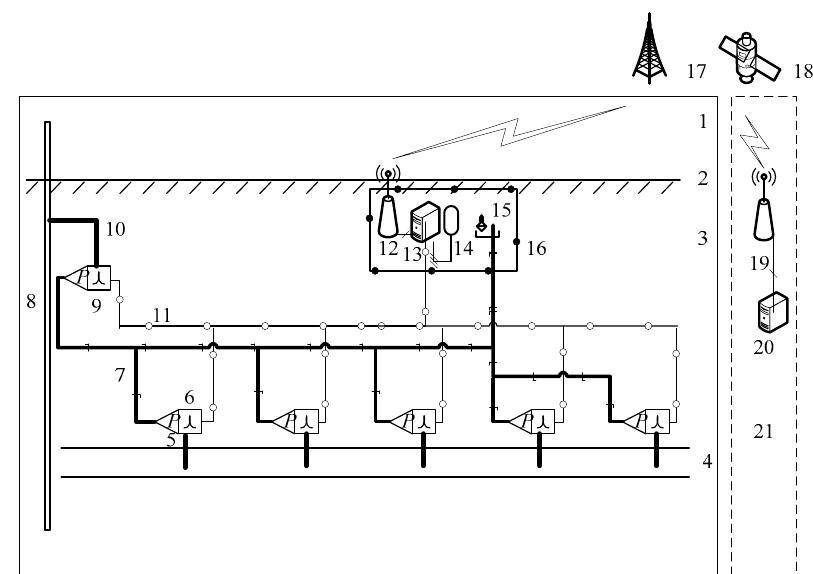
Figure 14. Principles of monitoring method of automatic monitoring system.